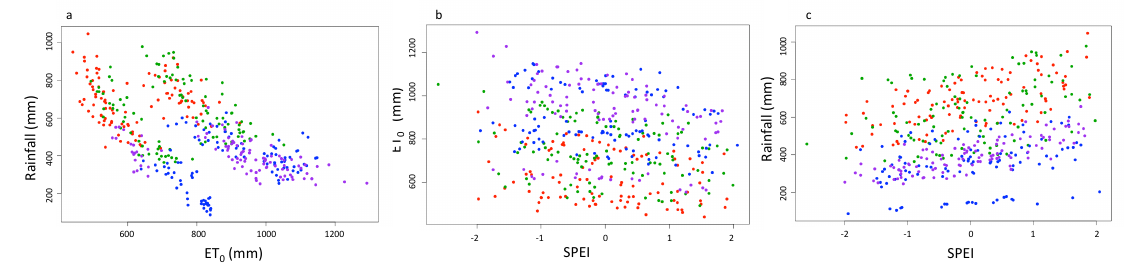
Figure A3. ( a ) The relationship between precipitation and ET 0 . ( b ) The relationship between precipitation and SPEI. ( c ) The relationship between ET 0 and SPEI. The regions are identified by the colors in each plot, with red indicating Burkina Faso, green is Mali, blue indicating Niger, and purple indicating